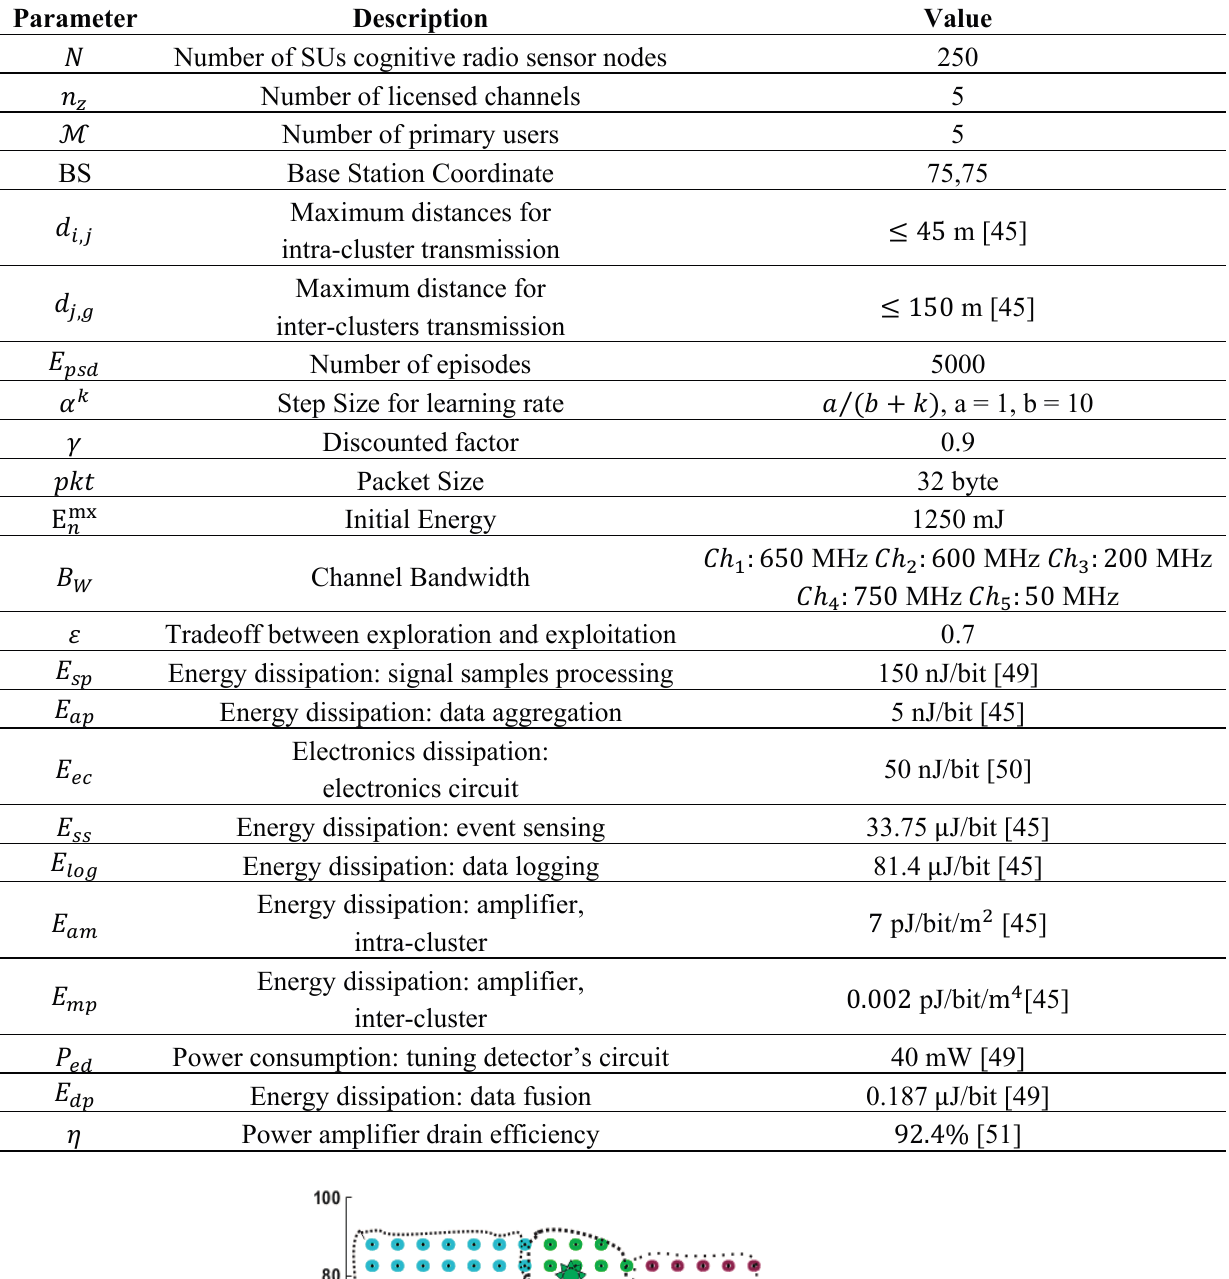
Table 3. Value of parameters used in the simulation.